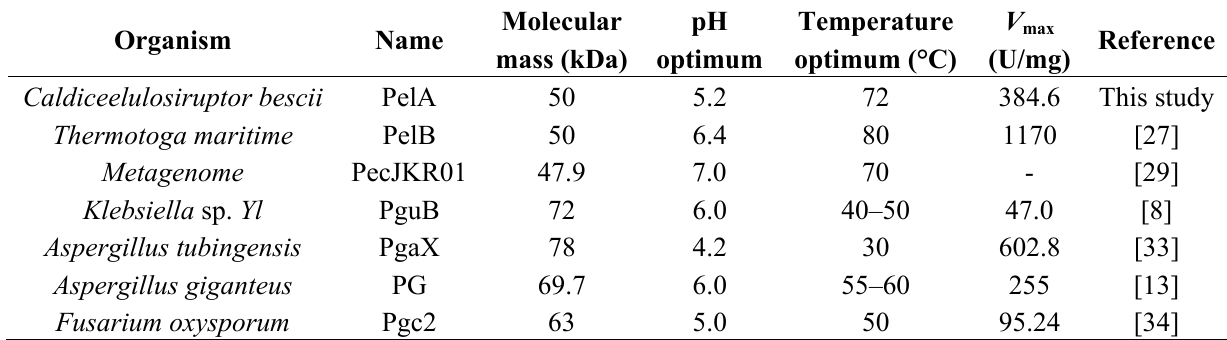
Table 1. Properties of CbPelA and other